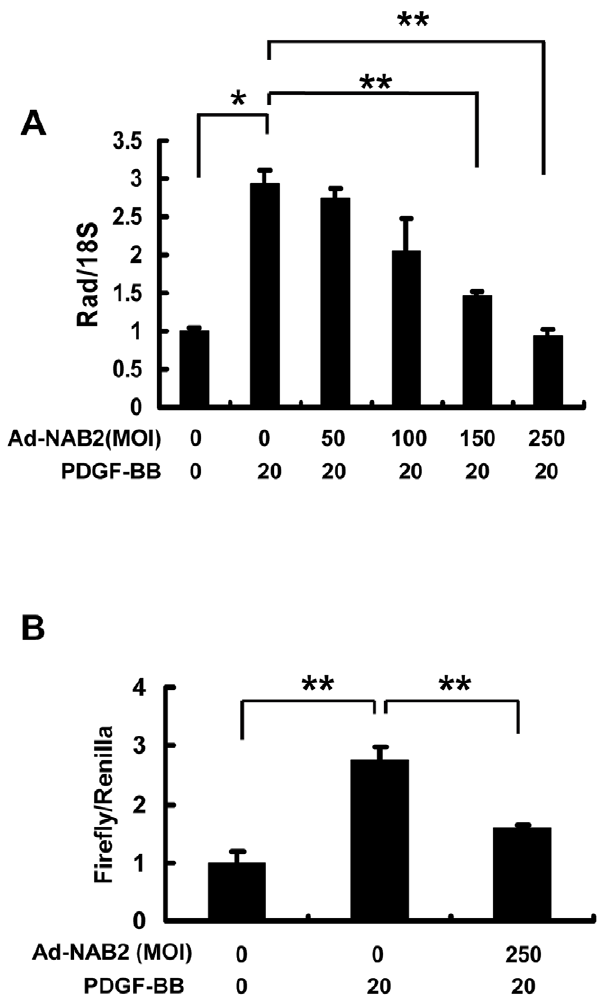
Figure 4. Egr-1 is an essential mediator for PDGF induced Rad expression. (A) RASMCs were infected with Ad-NAB2 at MOI of 0, 50,100,150 and 250 before treated with PDGF-BB (20 ng/ml) for 1 hour. Ad-GFP was added to keep the amount of adenovirus consistent. Rad mRNA was quantified using real-time PCR (n=3, * p , 0.05, ** p , 0.01); (B) RASMCs were transfected with pRad-155 and infected with Ad-NAB2 or Ad-GFP for 24 hours and then stimulated with PDGF. Luciferase activity was measured 1 hour after PDGF stimulation (n=4, * p , 0.05, ** p , 0.01).